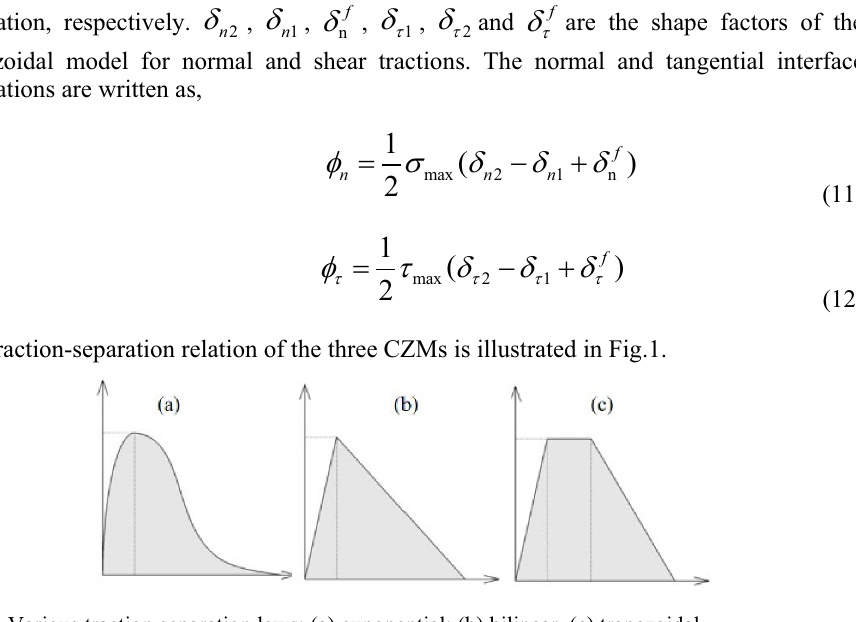
Fig. 1. Various traction separation laws: (a) exponential; (b) bilinear. (c) trapezoidal.